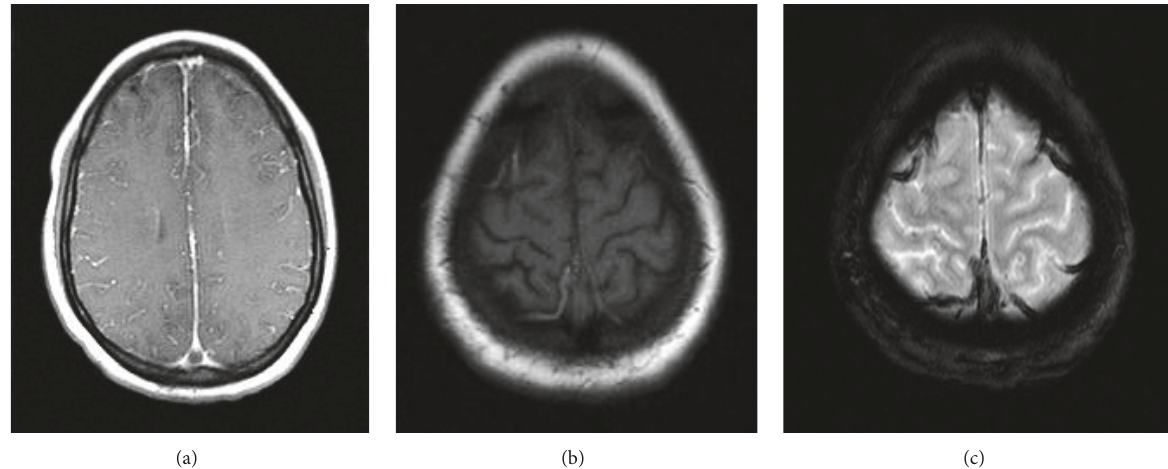
Figure 5: MRI brain with and without contrast showed the MRI equivalent of the “empty delta sign” (a) on postcontrast T1 images. Note the hyperintense cortical veins on T1 (b), which correspond with hemosiderin deposits on GRE (c).